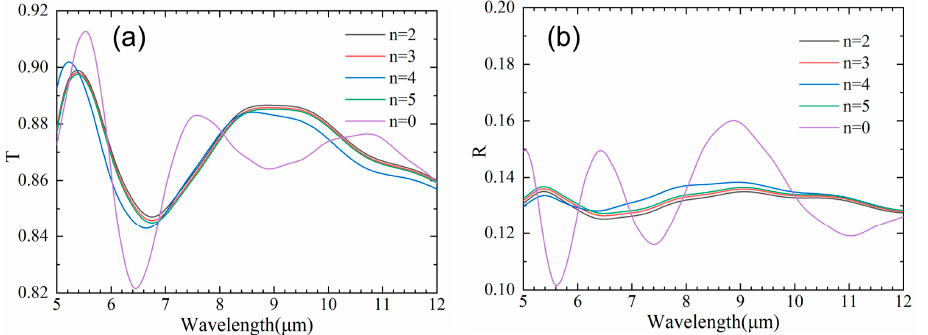
Figure 5. Simulated infrared transmittance ( a ) and reflectance ( b ) spectra of hybrid micro/nanostructure with various numbers of nanoripples.